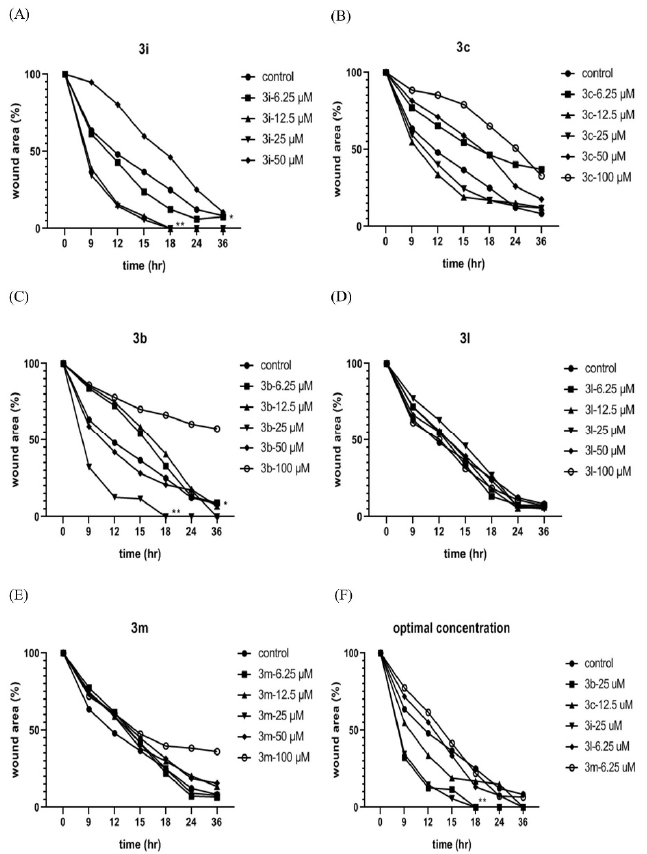
Figure 3. The migration of HaCaT cells treated with various doses of the derived compounds. Cells were treated with ( A ) 3b , ( B ) 3c , ( C ) 3i , ( D ) 3l , and ( E ) 3m at different concentrations for 24 h and subjected to the scratch assay. ( F ) Comparisons of the five compounds at their respective best concentrations after 24-h treatment in HaCaT cells subjected to scratch assay, expressed as a percentage of control (set as 100%). * p < 0.01, ** p < 0.001.